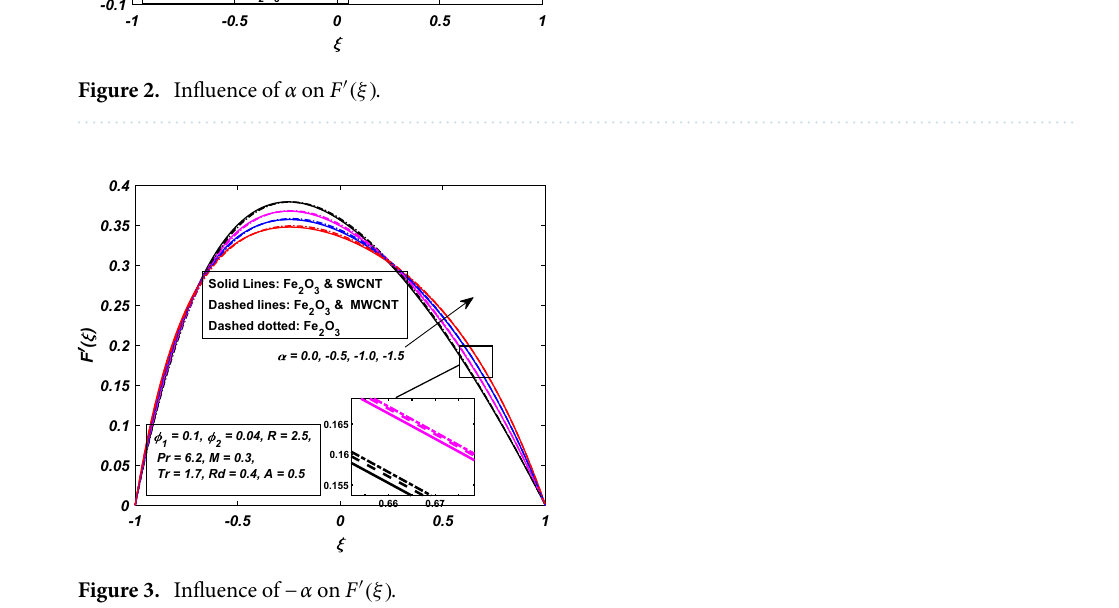
Figure 3. Influence of − α on F ′ (ξ) .